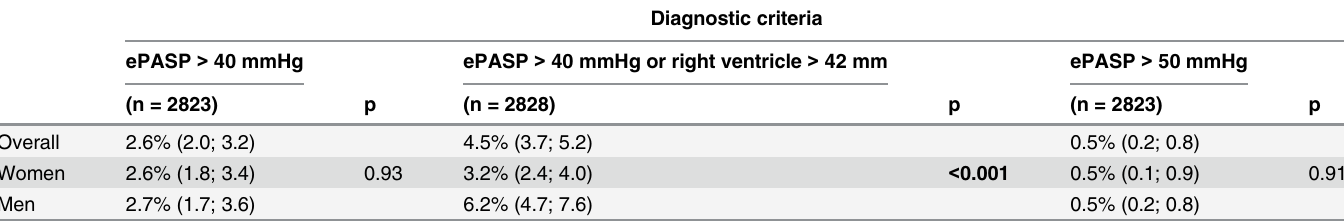
Data are shown as prevalences (95% con fi dence interval) RAP = right atrial pressure; TRV = tricuspid regurgitation velocity; ePASP = pulmonary artery systolic pressure, calculated as 4 * TRV 2 + RAP. If RAP could not be estimated, the case de fi nition was based on TRV > 3.0 m/s and 3.4 m/s to correspond to ePASP > 40 mmHg and 50 mmHg, respectively Participants with absent or too-small-to-measure TRV were included as